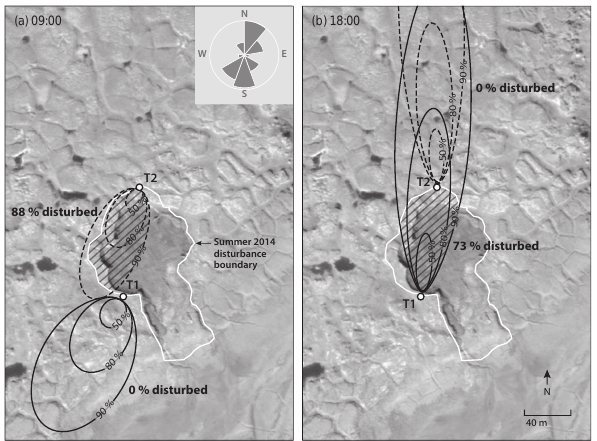
Figure 2. Turbulent source areas for two time steps on day of the year (DOY) 186 ( (a) 09:00 and (b) 18:00), with ellipses display- ing areas contributing to the given percentage of the signal from each instrument tower (T1 and T2). Three ellipses from each tower represent the 50, 80, and 90% cumulative source area. The shaded area represents a signal from the disturbed part of the surface. The white polygon represents the furthest extent of headwall retreat, as the initial image was taken in July 2013 (Worldview-2) and signif- icant retreat occurred between image acquisition and the summer 2014 sampling